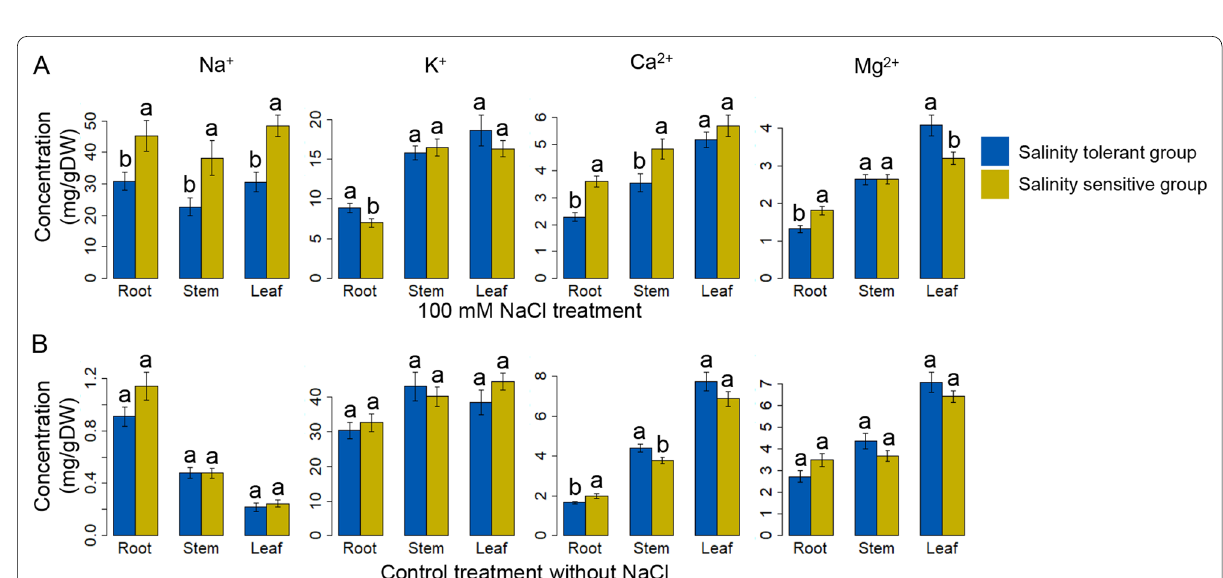
Fig. 3 Concentrations of four mineral ions (Na + , K + , Ca 2 + , and Mg 2 + ) in roots, stems, and leaves for salinity-tolerant/sensitive groups. Twenty accessions, consisting of eight tolerant (green: SES scores 2–4) and 12 sensitive (red: SES scores 4–9) accessions, were selected from the initial